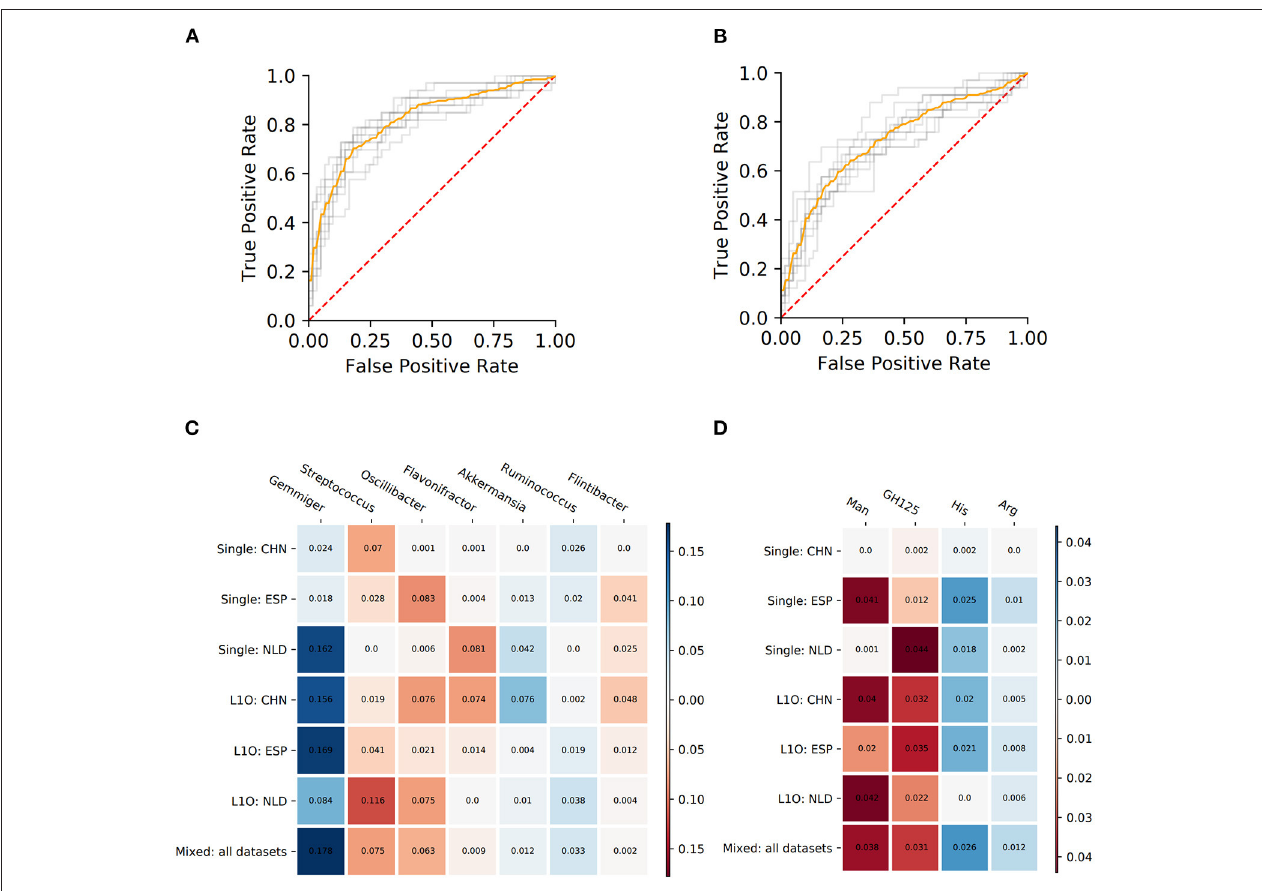
FIGURE 5 | Performance characteristics and stable predictors for the UC-vs.-HC classifier. (A,B) ROC curves for the Mixed strategy for UC-vs.-HC classifier construction with taxonomic (A) and phenotypic (B) predictors. (C,D) Stable predictor importance values in different classification variants for taxonomic (C) and phenotypic (D) predictors. Color saturation corresponds to the mean importance of the predictor (see color key). Color hue corresponds to the direction of the difference between HC and UC means (blue—increased in HC, red—increased in